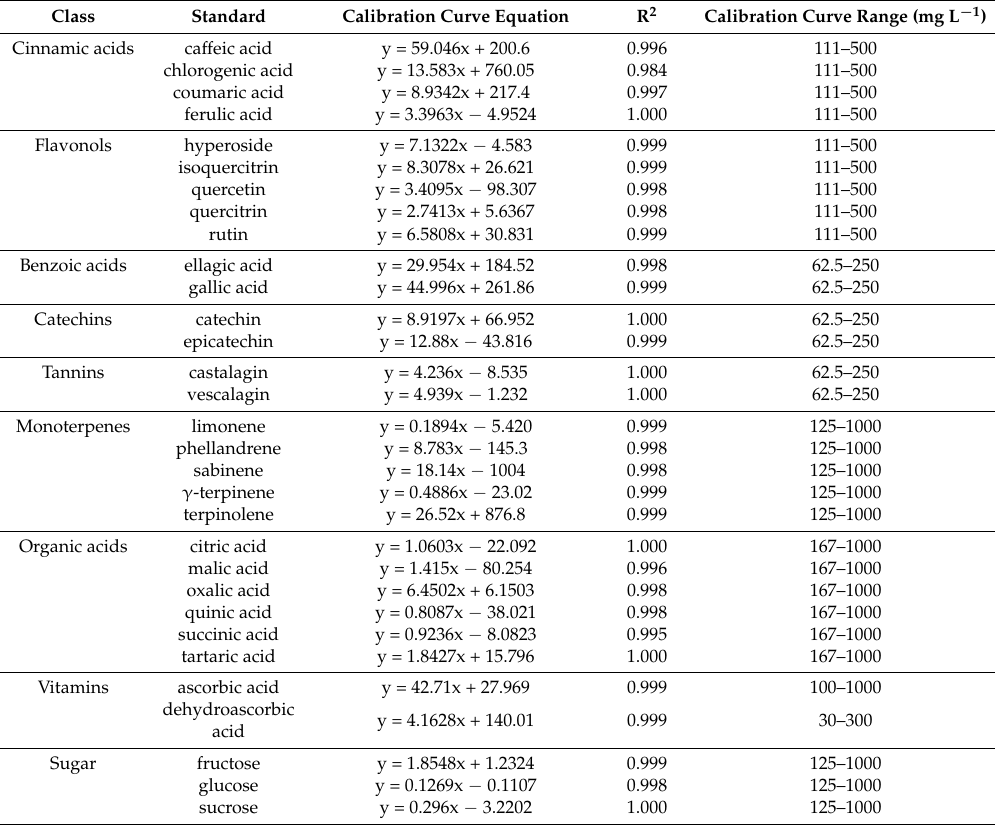
Table 6. Calibration parameters for all the used analytical